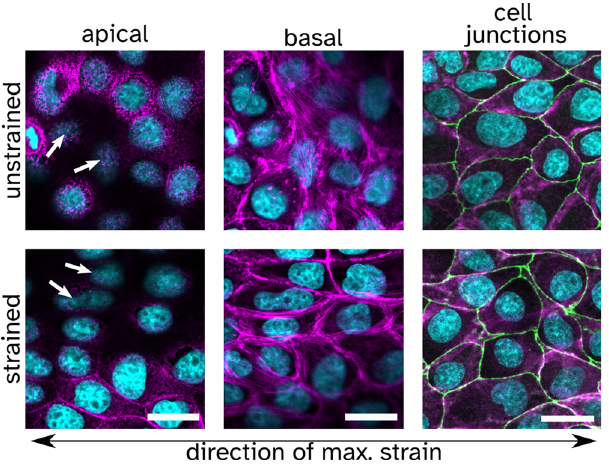
Fig. 2 Immunostained con fl uent MDCK II cells showing the F- actin (Phalloidin 546) in magenta, the cell junction protein ZO1 in green (anti-ZO1 Alexa Fluor 488 monoclonal antibody), and the nucleus in cyan (DAPI). The apical and basal parts, as well as the cell junctions of the layer in a strained and unstrained state, are shown, respectively. The arrows point to locations in the unstrained and strained state where the microvilli's number and structure can be compared. Scale bar is 20 μ m. Fig. 3 The changes in the mechanical properties of cells due to strain. For